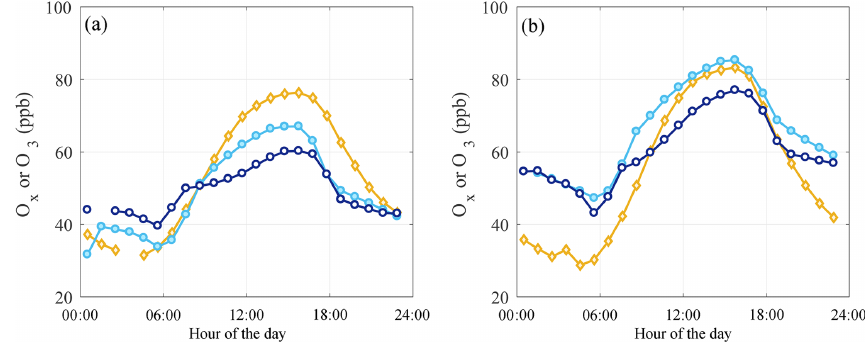
Figure 4. Hourly mean O x in Visalia (orange diamonds), SEQ1 (cyan filled circles), and SEQ2 (dark blue open circles) in springtime (a) and during the O 3 season (b) 2001–2012. Data gaps are due to routine